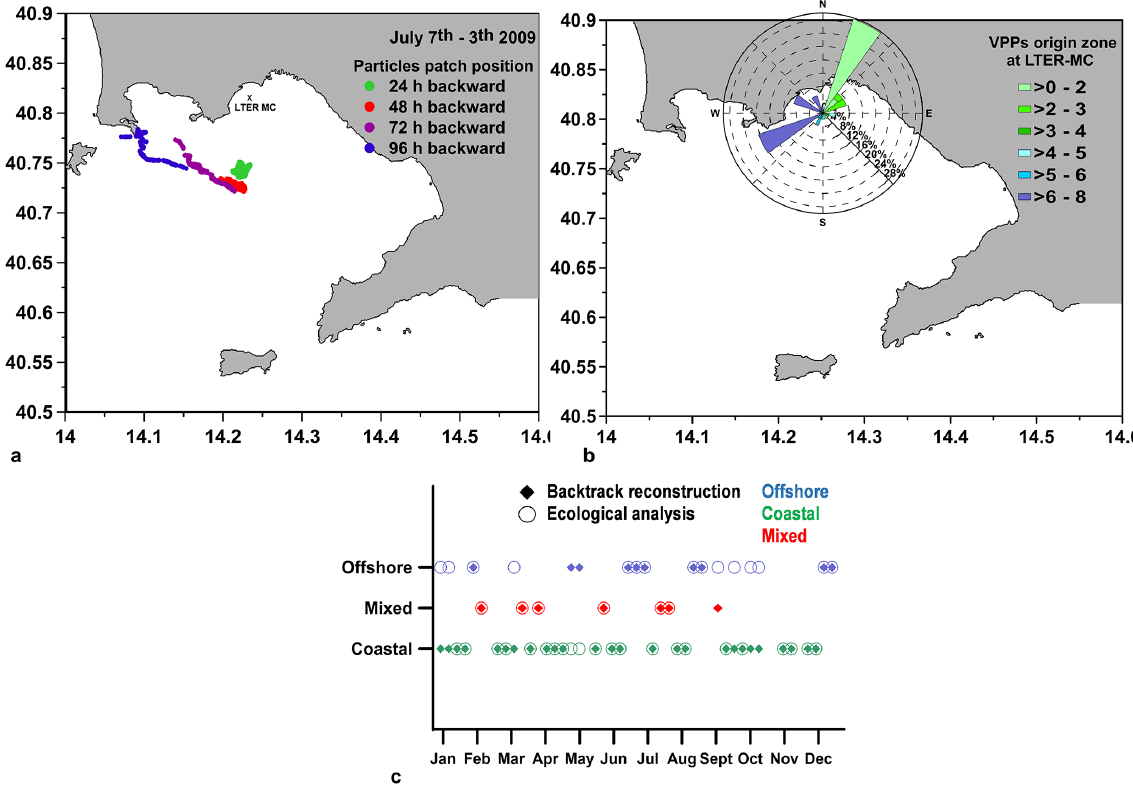
Figure 14. (a) Map of the Gulf of Naples (southern Tyrrhenian Sea) showing the (a) Lagrangian backtracking trajectories of virtual phyto- plankton patches (VPPs) in the period 3–7 June 2009 and (b) main origin sectors of the VPPs at the LTER-MC site resulting from backward simulations; index sectors of VPPs are 1–2–3–4–5 for coastal areas and 6–7–8 for offshore areas. (c) Comparison among backtracked La- grangian origin and ecological analysis based on salinity and Chl a data measured weekly at LTER-MC. Green: VPPs originating from coastal areas; blue: VPPs originating from offshore areas; red: VPPs originating partly from coastal and partly from offshore areas. Adapted from Cianelli et al.